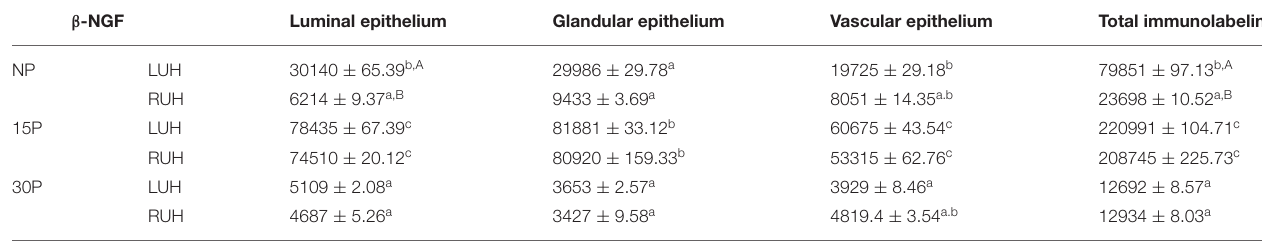
TABLE 2 | Densitometry analysis of β -NGF immunolabeling in alpaca endometria. β